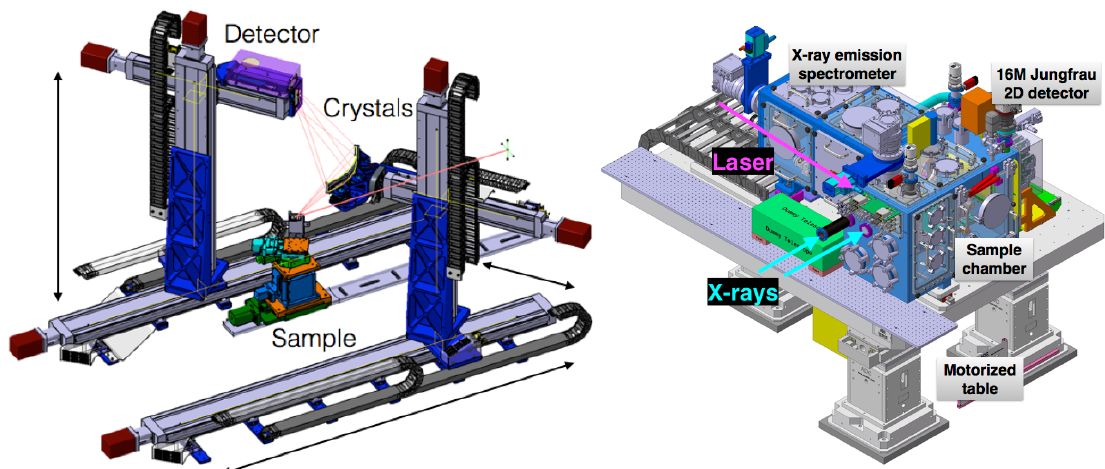
Figure 15. The instruments installed at Experimental Station Alvra (ESA). The ESA Flex instrument ( left ) is a flexible X-ray spectrometer that can be positioned according to the experimental requirements. The ESA Prime instrument ( right ) is a combined scattering and spectroscopy chamber designed to allow experiments in neutral, vacuum, or He atmosphere. ESA Prime is focussed on allowing experiments to be performed in the 2–5keV tender X-ray